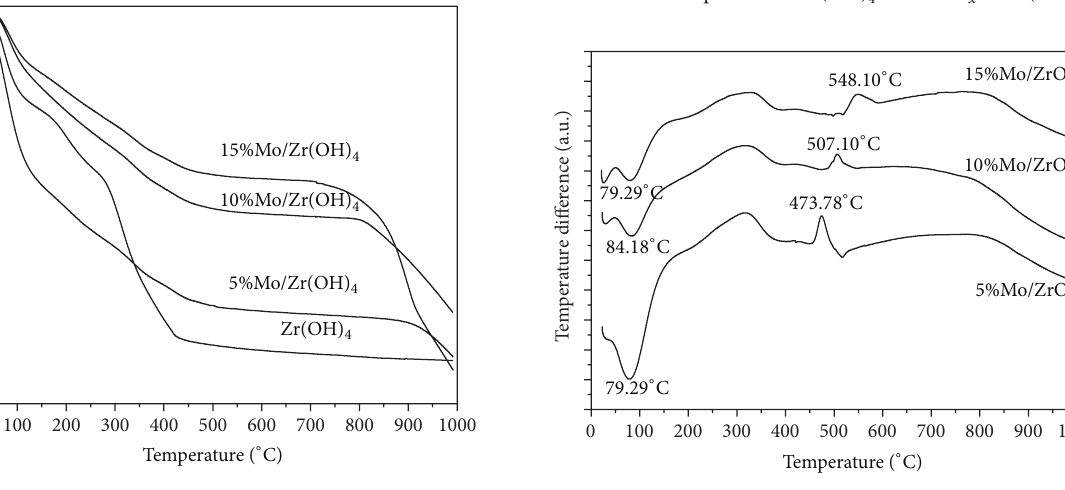
Figure 4: DTG profiles of Zr(OH) 4 and MoO 𝑥𝑦− /Zr(OH) 4 .